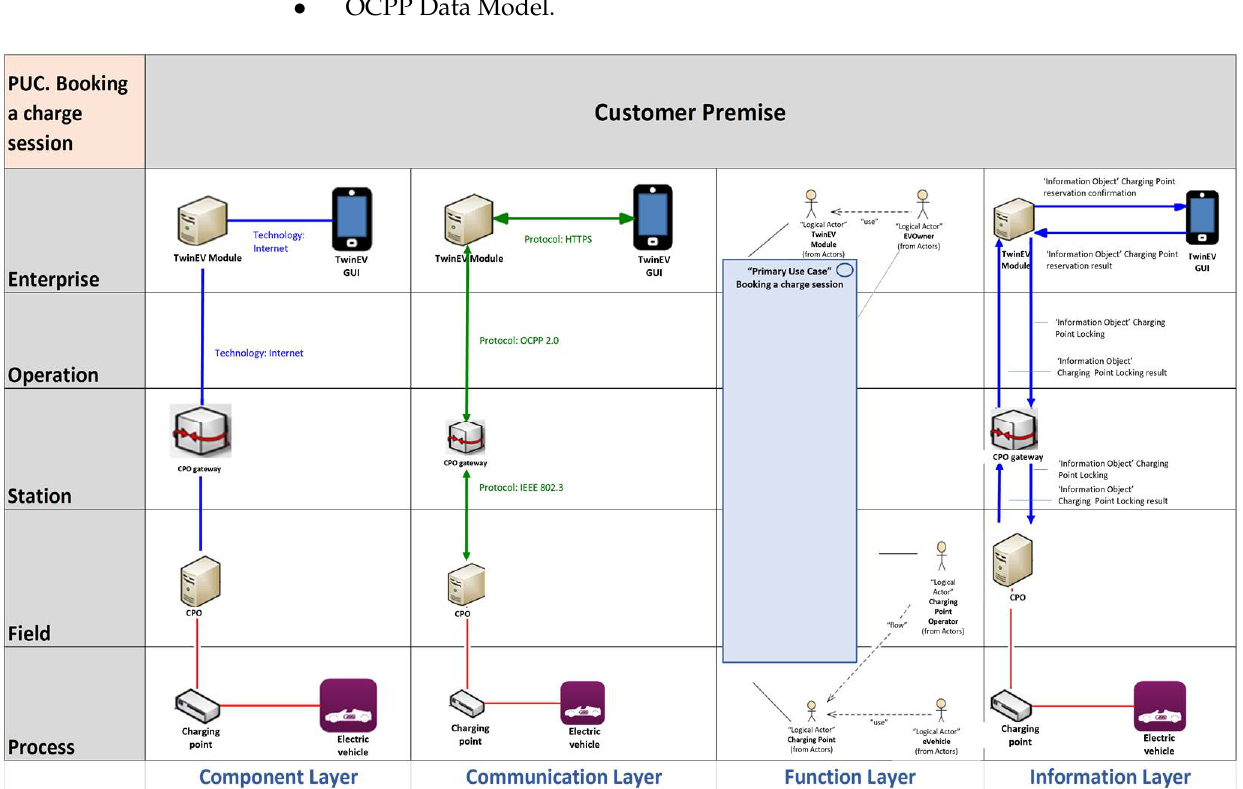
Figure 5. SGAM Component, Communication, Function, and Information layers of the PUC sce- nario.